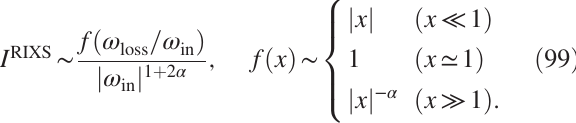
; ω =D ¼ 0 . 5 , T=D ¼ 10 − 5 , Γ =D ¼ 0 þ ). (a),(b) Color-scale plots using linear for the MIM ( U p p in loss Þ , for several fixed values of ω (indicted by dots placed at loss in and j ω interchanged. The power laws revealed in (c) and (d) are summarized loss in j and ω in j loss